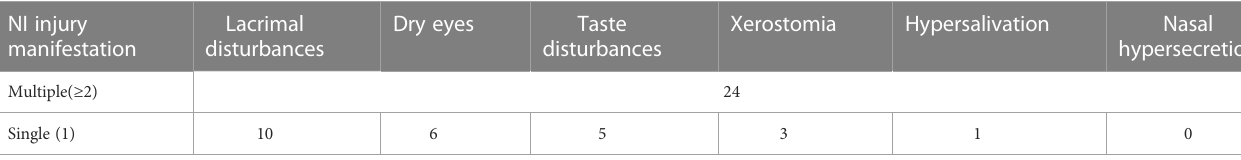
TABLE 2 Postoperative manifestations of NI injury in VS